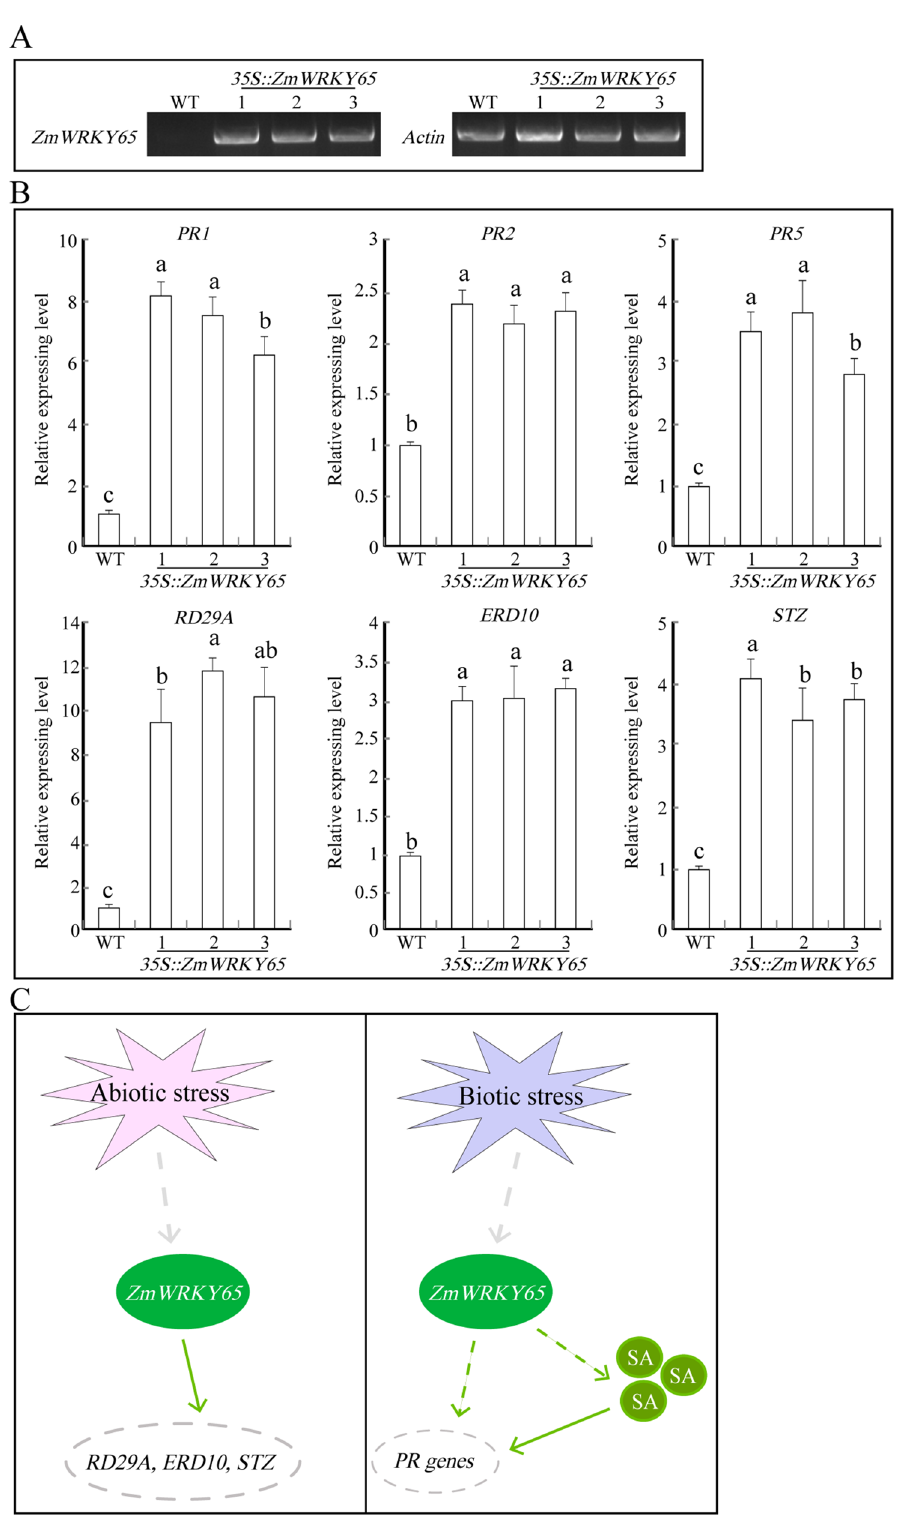
Figure 8. Expression analysis of stress-responsive genes in ZmWRKY65 transgenic Arabidopsis . ( A ) The transcription levels of ZmWRKY65 in transgenic Arabidopsis plants. ( B ) The transcription levels of stress-related genes in transgenic Arabidopsis plants. Arabidopsis Actin (ACT2) was used as an internal control. Vertical bars indicate ± SE of three replicates. ( C ) The mode of ZmWRKY65 gene